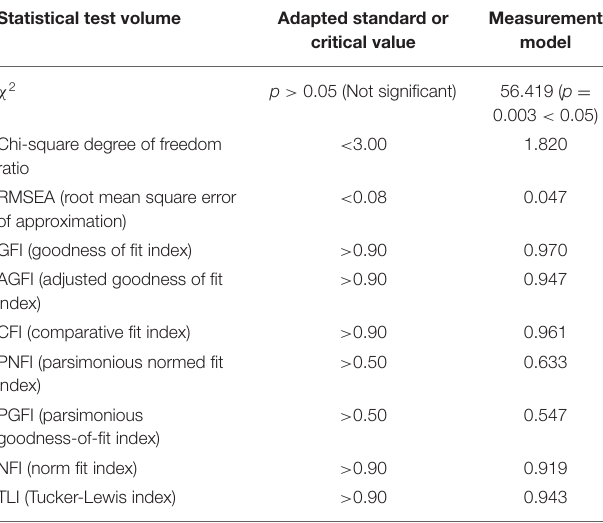
TABLE 9 | Model fitness test results after